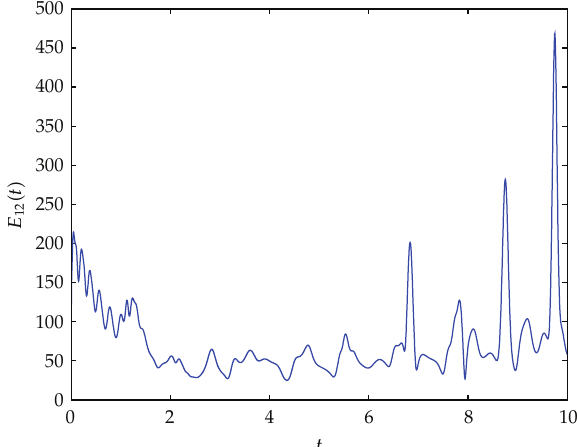
Figure 2: Time evolution of the synchronization errors E 12 (cid:6) t (cid:7)